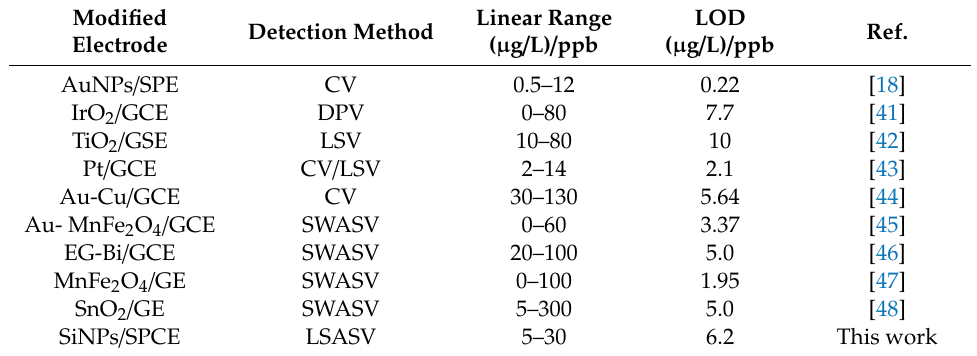
Table 1. Comparative study on the performance of different electrochemical sensors for arsenite detection.